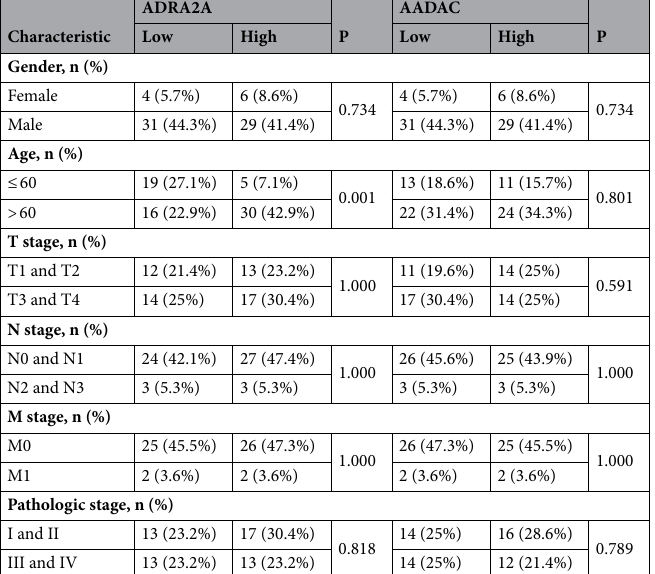
Table 1. Clinical baseline data of EAC patients in TCGA